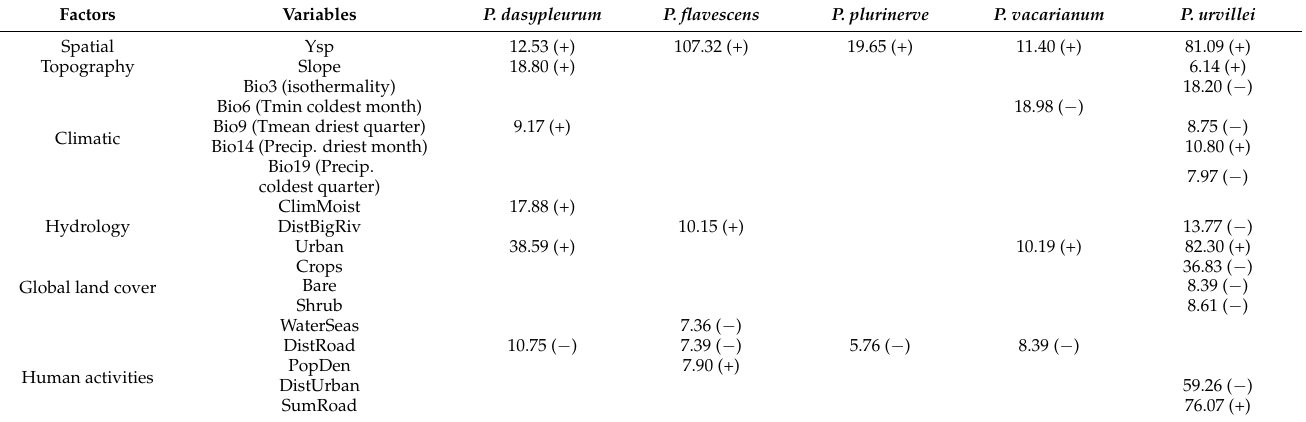
Figure 1. Favourability models for each of the five sexual species of the Dilatata group based on predictor variables from different factors: spatial configuration, topography, climatic, hydrology, global land cover, and human activities (see Table A1). The zoom of each favourability model (bottom maps) shows the species occurrences (white circles) and the occurrence of genotypes used for germination assays (red triangles). Table 1. Explanatory variables, and factors they belong to, for each of the five sexual species of the Dilatata group in the SDMs obtained. Wald parameter values (according to Wald’s test) for predictor variables included in each favourability model indicate the relative importance of each variable. Bold numbers highlight the four most significant predictor variables of each SDM. Signs in brackets show the positive or negative relationship between favourability and the variable. Abbreviations and sources of each predictor variable are noted in Table